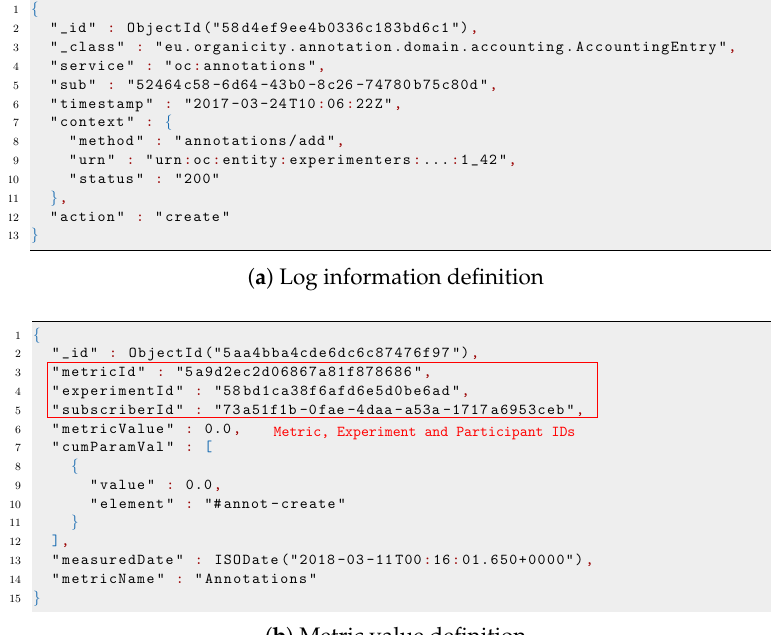
Figure 6. Illustrative examples of the log information and value obtained by one metric, for one